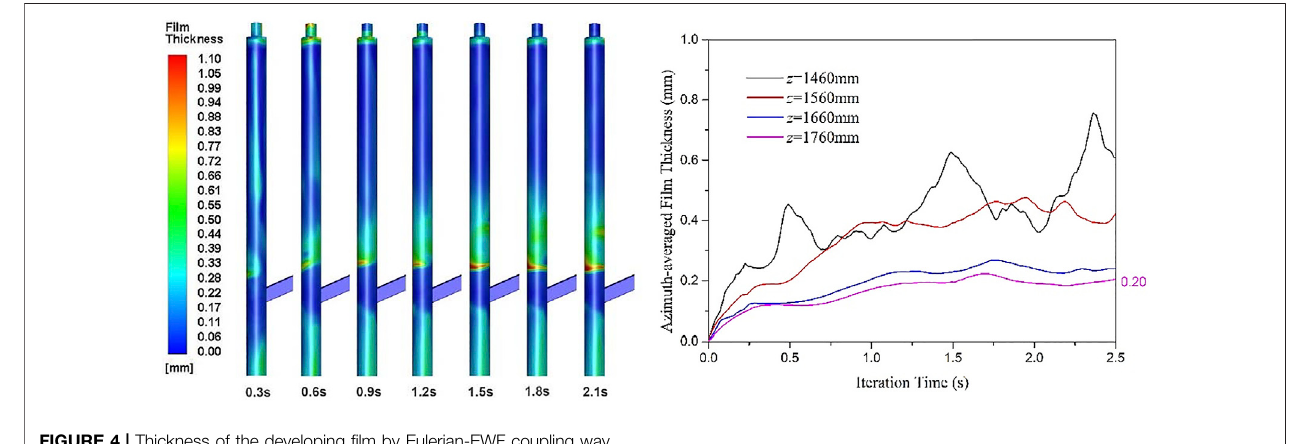
FIGURE 4 | Thickness of the developing fi lm by Eulerian-EWF coupling